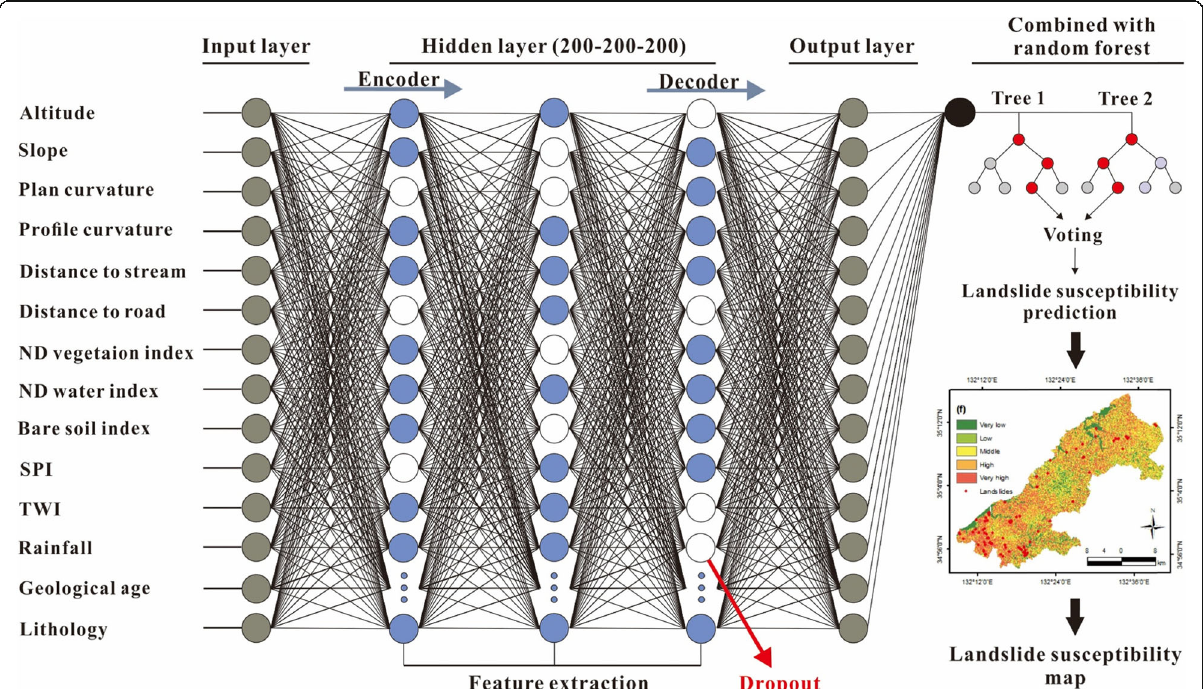
Fig. 8 Architecture of sparse autoencoder combined with random forest employing reconstruction error value by anomaly